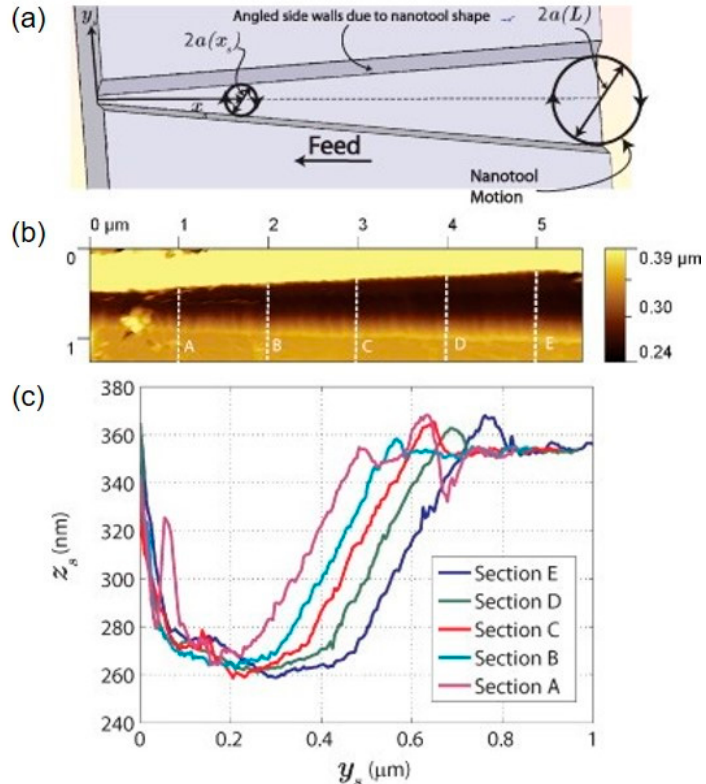
Figure 9. Nanochannel with variable width fabricated by nanomilling approach: ( a ) the schematic diagram of variable width fabrication method, ( b ) the AFM image of nanochannel, ( c ) the cross-section views of section A, B, C, D and E [87] .